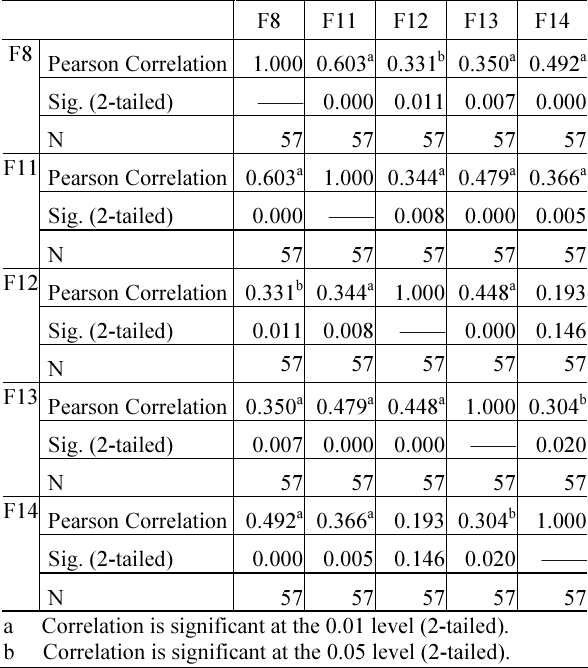
Table 9. P earson Correlations for Component 1 in Factor Analysis for Driving